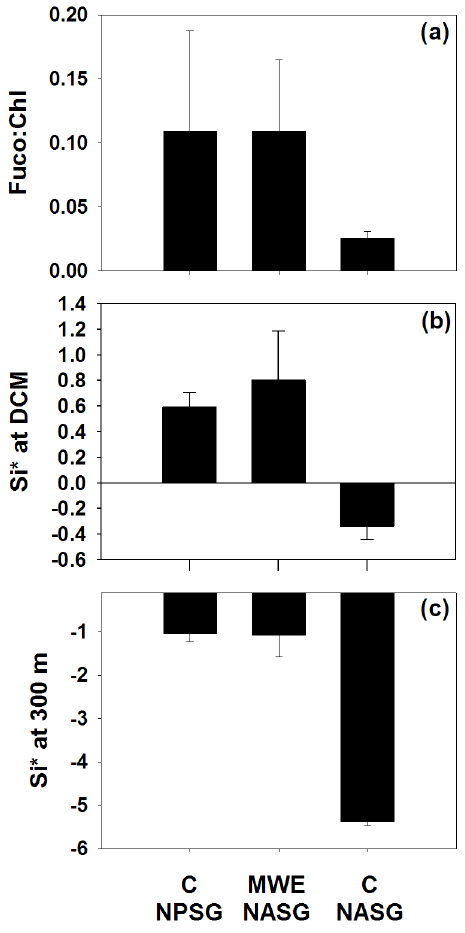
Fig. 3. The biological community sustained at the deep-chlorophyll maximum (DCM) at the central station of the three eddy types de- scribed in the paper, two from the Sargasso Sea (NASG) (MWE, n = 2, and cyclonic eddy, C, n = 4) and one from the Hawai’i re- gion of the NPSG (cyclonic eddy, C, n = 2). The DCM at the eddy centre station from each feature was sampled multiple times; aver- ages are shown for each eddy type. The y-axis represents the ratio of fucoxanthin:chlorophyll- a (a) , Si ∗ at the DCM (µmoll − 1 ) (b) , and Si ∗ at 300m (µmoll − 1 ) (c) . Standard error bars are